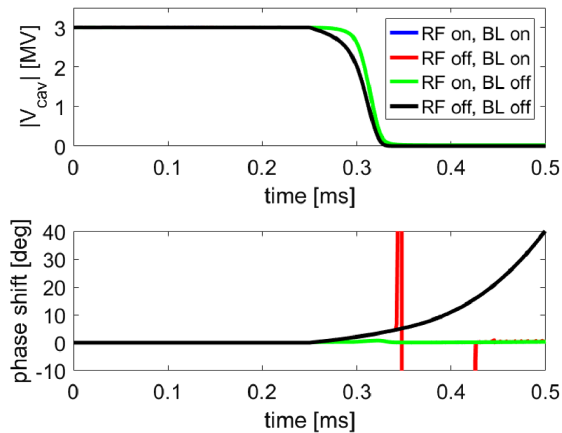
FIG. 11. Plots of cavity voltage amplitude (top) and phase (bottom) for an HL-LHC cavity at 2K during a quench, comparing the effects of the rf system and beam loading.